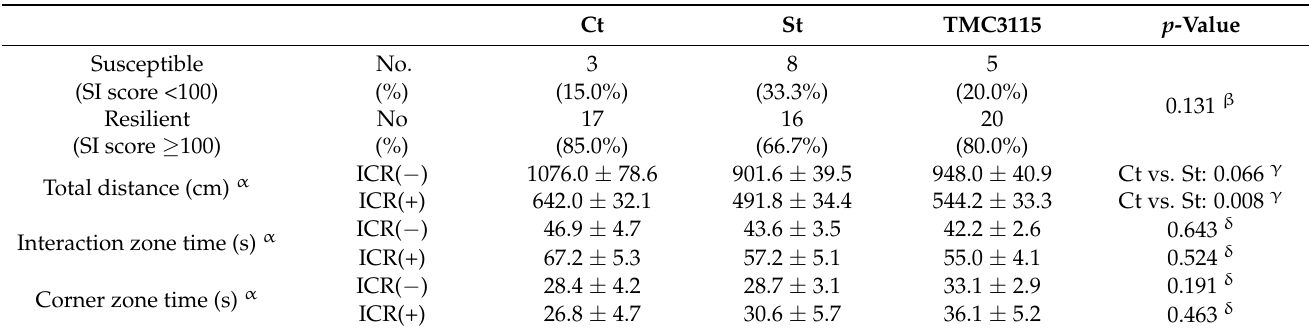
Table 1. Summary of SI test.